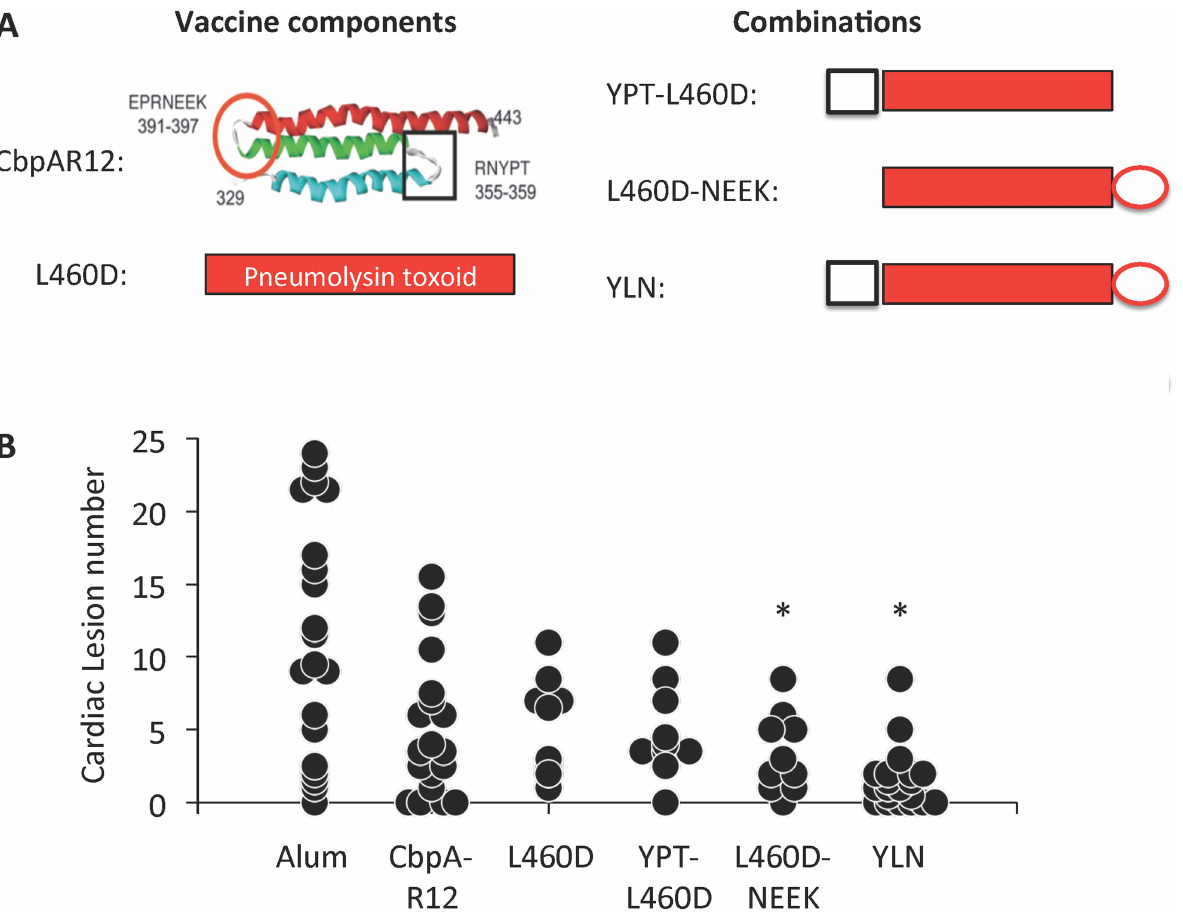
Figure 5. YLN immunized mice are protected against lesion formation. A) Top left: Schematic representation of the anti-parallel helices of R domains of CbpA. Square: binding site for polymeric immunoglobulin receptor showing amino acids at the turn (i.e. YPT); Circle: binding site for LR showing amino acids at the turn (i.e. NEEK). Top right: Schematic representation of various fusion protein derivatives of CbpA and the pneumolysin toxoid L460D used for vaccination. YLN is identified as composed of YPT-L460D-NEEK in our studies. B) Cardiac lesion number per individual mouse (circle) at 30 h post infection obtained from immunized mice. Experimental cohort size: Alum=20; CbpA-R12=19; L460D=10; YPT-L460D=10; L460D-NEEK=10; YLN=20. Asterisks denote a statistical significant difference versus the alum control. Statistical analysis was done using Kruskall- Wallis a One-way ANOVA on Ranks.